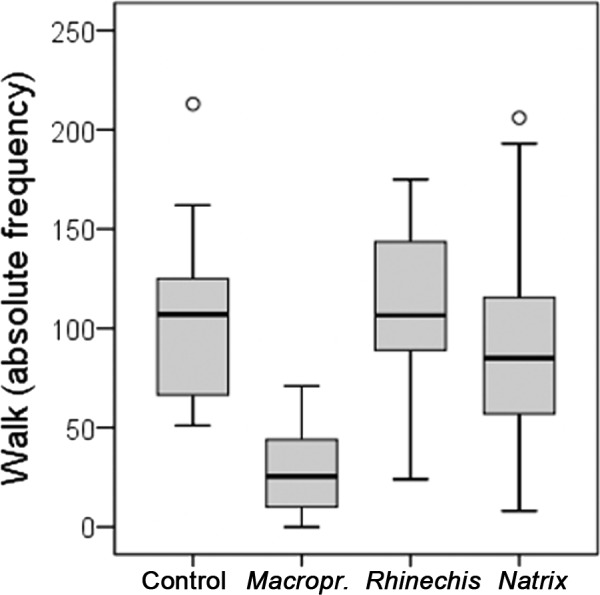
Boxplots of the absolute frequencies of normal movements, or ‘walk’, in number of movements, of Podarcis siculus lizards of Es Canutells (Menorca, Spain) for the four treatments (Macroprotodon mauritanicus, Rhinechis scalaris, Natrix maura, and the odourless control).